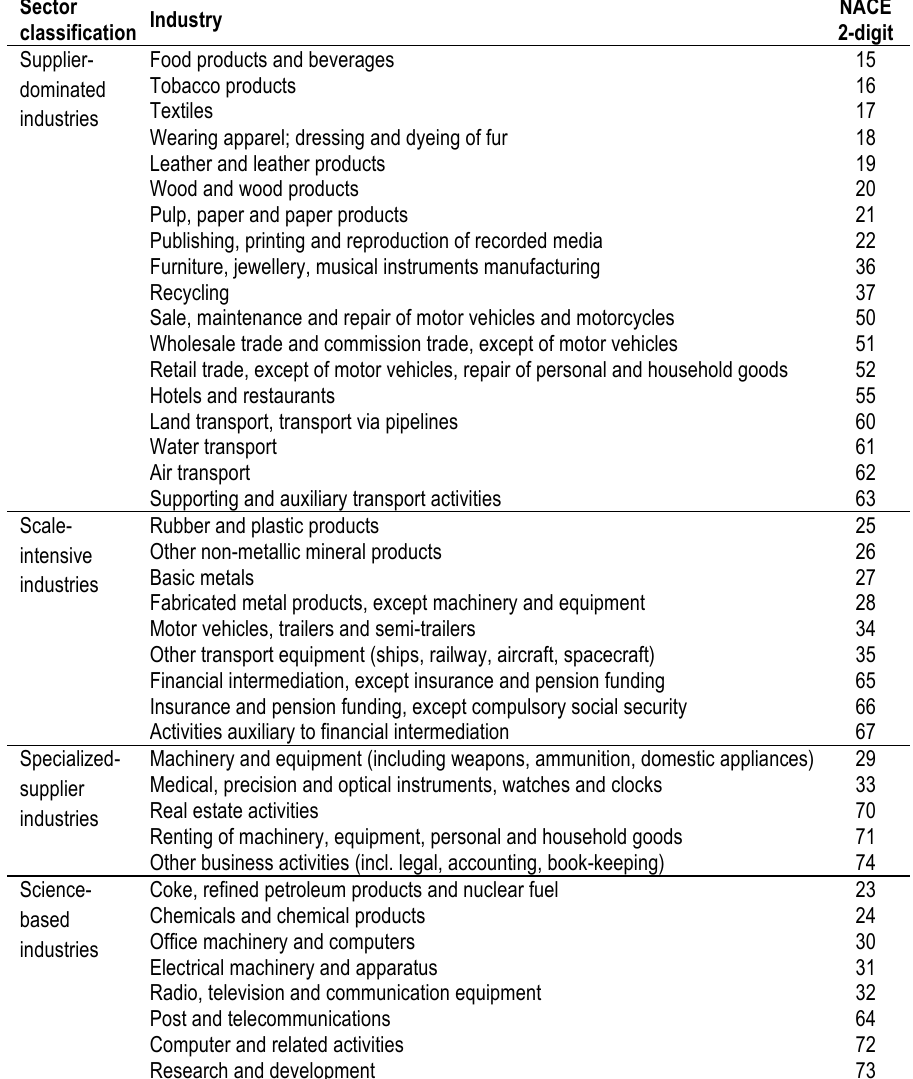
Table 1. Revised Pavitt’s sectoral taxonomy - Source: Cantner and Savin